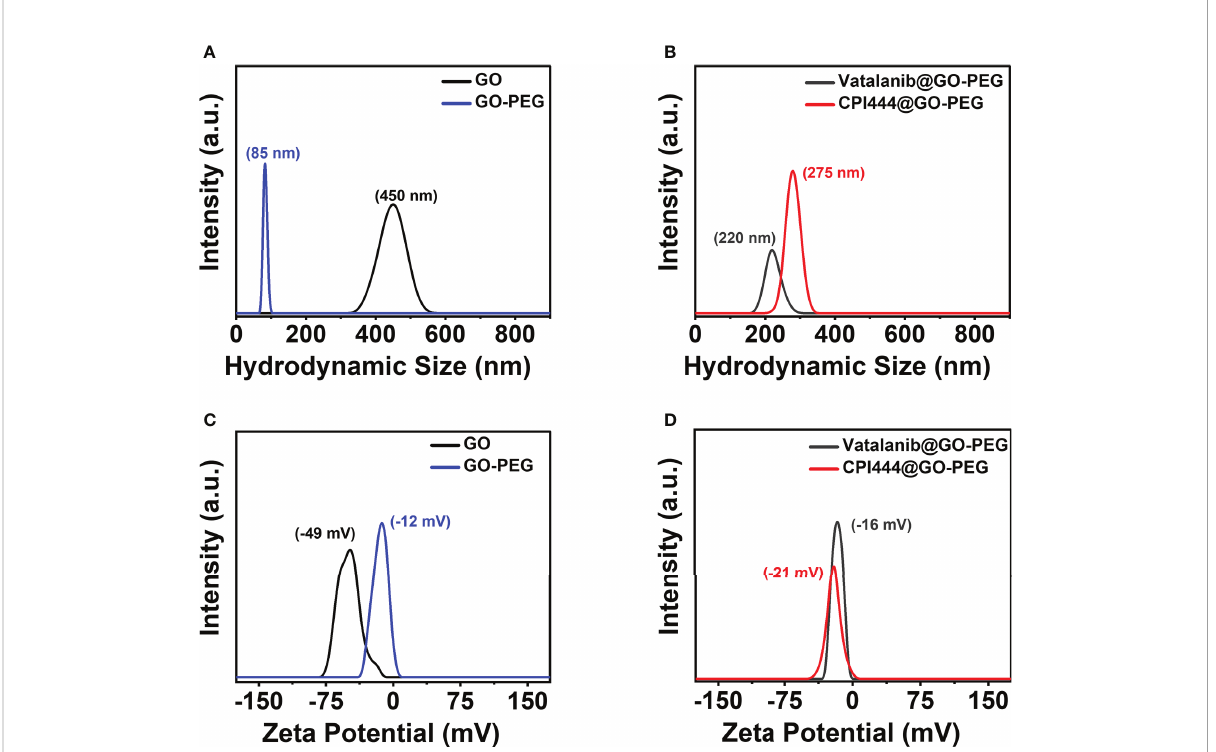
FIGURE 4 Dynamic Light Scattering measurements. (A, B) Hydrodynamic size, and (C, D) Zeta potential of GO, GO-PEG, vatalanib@GO-PEG and CPI444@GO-PEG,